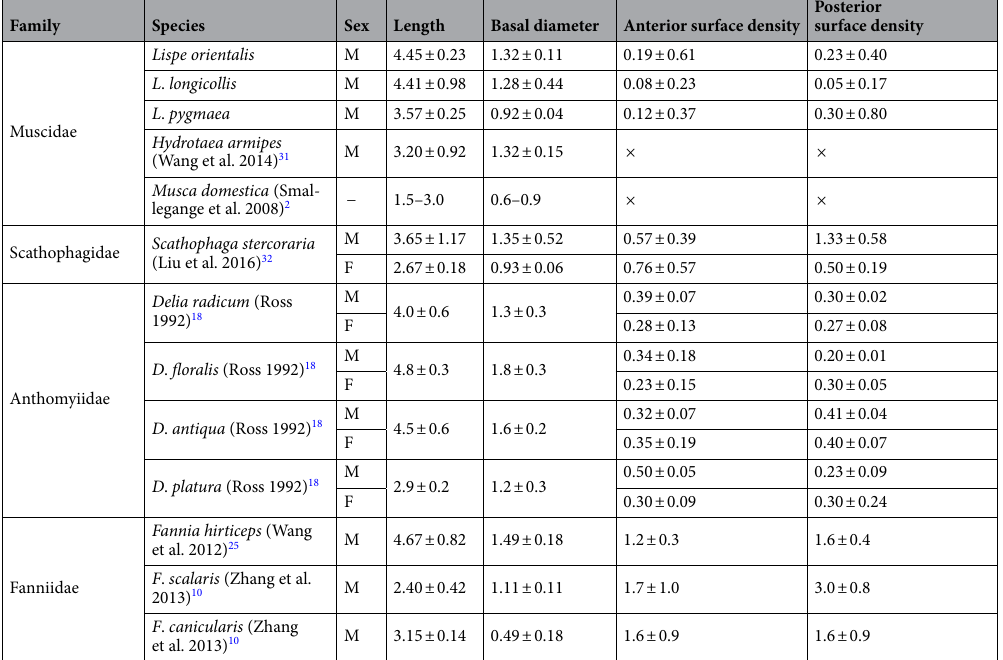
Table 4. Length, basal diameter (μm ± SD) and average density (10 −3 μm −2 ± SD) of coeloconic sensilla on antennal postpedicel of muscoid species. M male, F female, − unidentified; × no